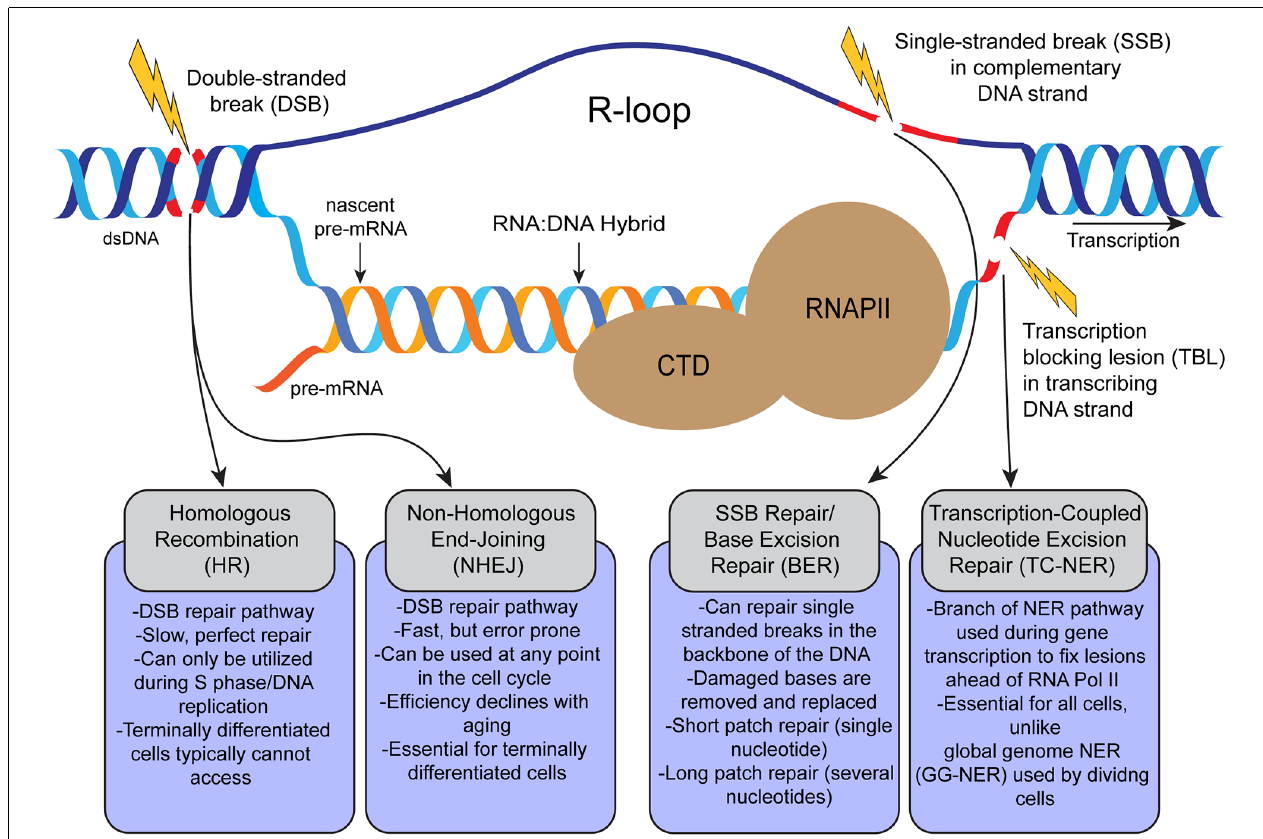
FIGURE 1 | Schematic representation of formation of transcription-coupled R-loops and possible DNA lesions that occur during transcription and related DNA repair pathways in the cell. R-loops are 3-strand nucleic acids structures formed during RNA Pol II (RNAPII)-dependent gene transcription. R-loops are composed of a nascent mRNA transcript hybridized to the transcribing DNA strand, and the displaced complementary DNA strand. Persistent pathogenic R-loops can result in DNA lesions such as single-stranded breaks (SSBs) and double-stranded breaks (DSBs) by various mechanisms. From left to right, DSBs can be repaired via homologous recombination (HR; in dividing cells), or non-homologous end-joining (NHEJ; in dividing and terminally-differentiated cells). Single stranded breaks (SSBs) can be repaired by base excision repair (BER). Transcription blocking lesions (broadly) are repaired through transcription-coupled nucleotide excision repair (TC-NER).